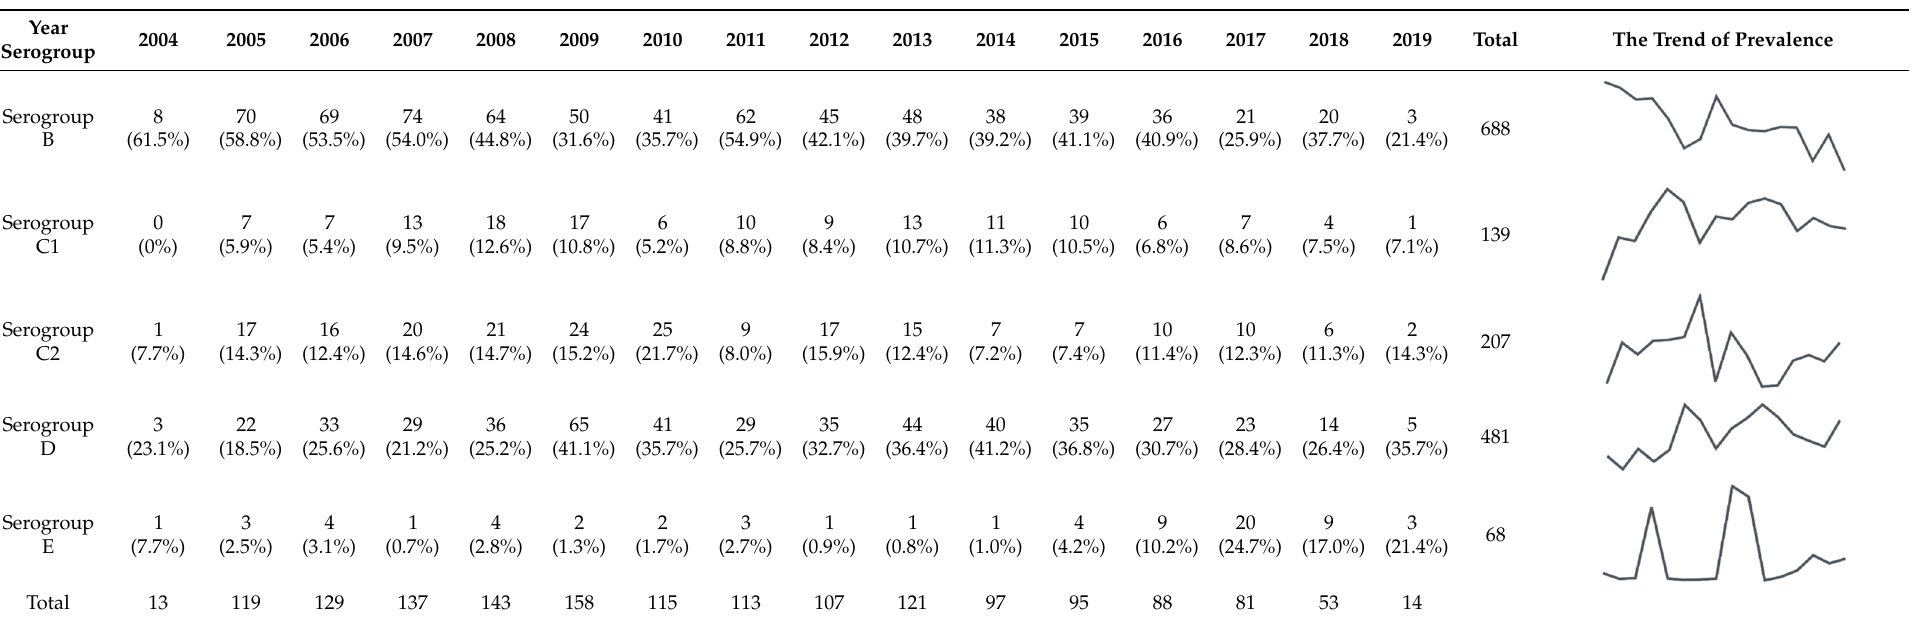
Table 1. The prevalence of different serogroups in each year.